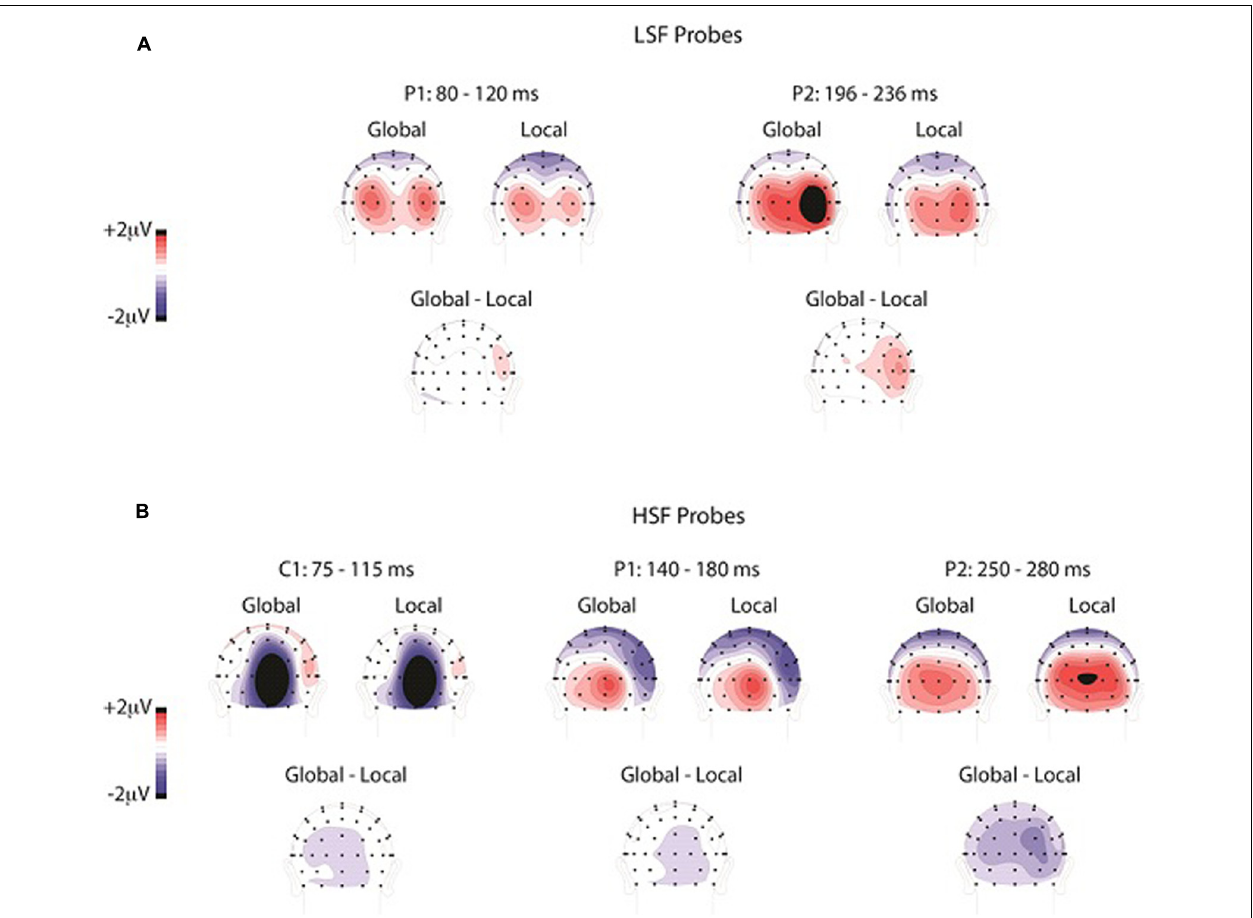
FIGURE 4 |The scalp distributions elicited by LSF (A) and HSF (B) probes during global attention, local attention, and the difference, shown during the latency ranges of the C1, P1, and P2.